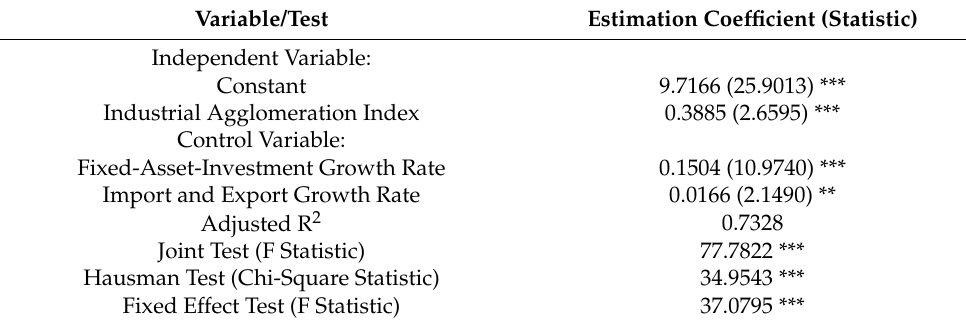
Table 3. The panel regression results.